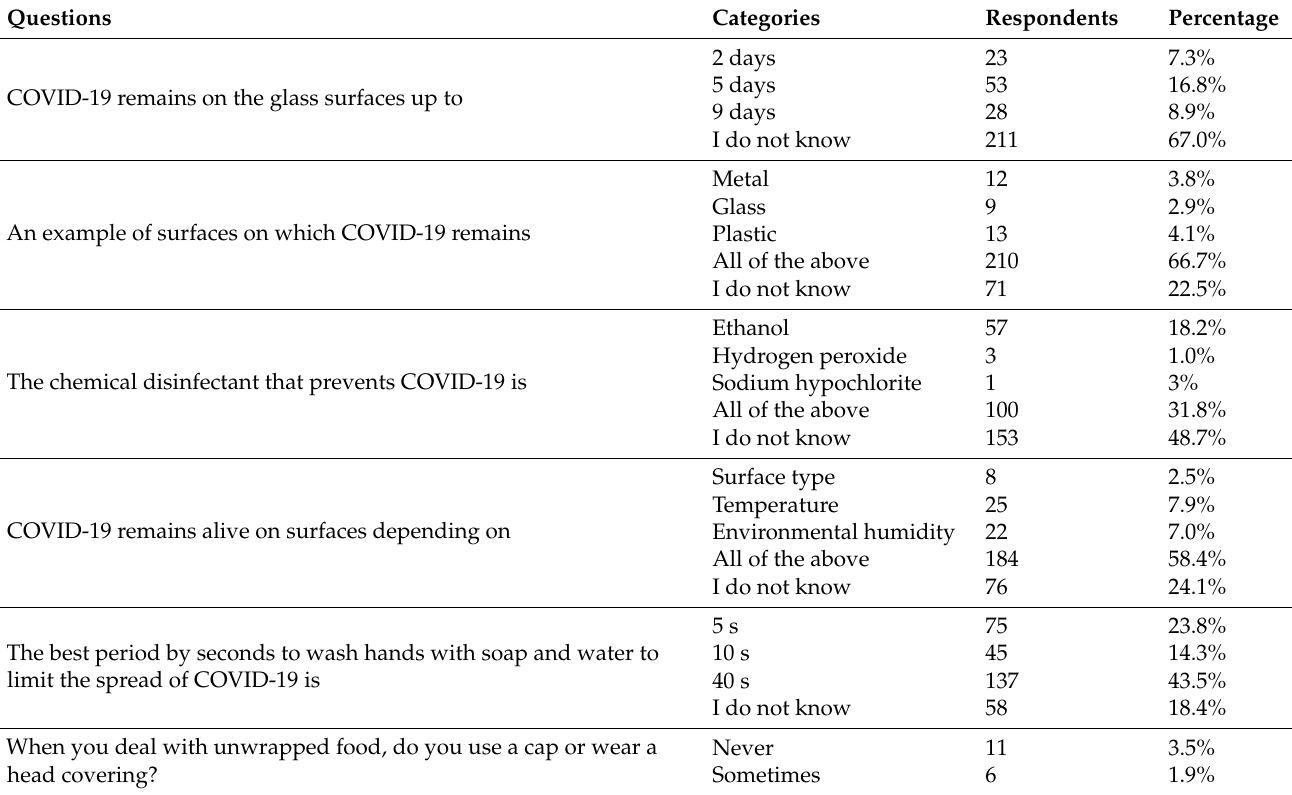
Table 5. Food handlers’ knowledge about